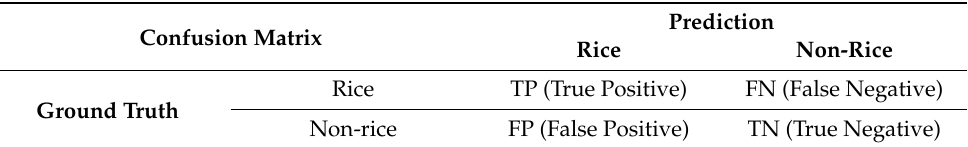
Table 1. Confusion Matrix (TP, FN, FP, and TN represent the number of pixels for each category, respectively. T and F refer to correct prediction and wrong prediction, respectively; P and N refer to the predicted results of rice and non-rice, respectively.).